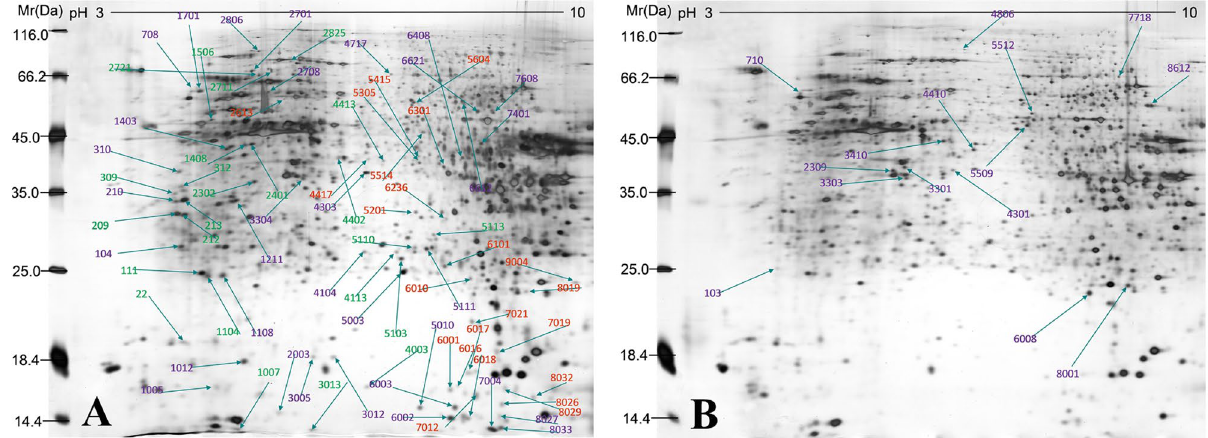
Figure 6. Representative two-dimensional difference gel electrophoresis (2D-DIGE) gel images. Isoelectric focusing (IEF) was performed using 24 cm immobilized pH gradient (IPG) strips covering a linear pH 3–10. ( A ) Shows a 2D gel of total protein from controls; ( B ) shows a 2D gel of total protein from H 2 O 2 - treated